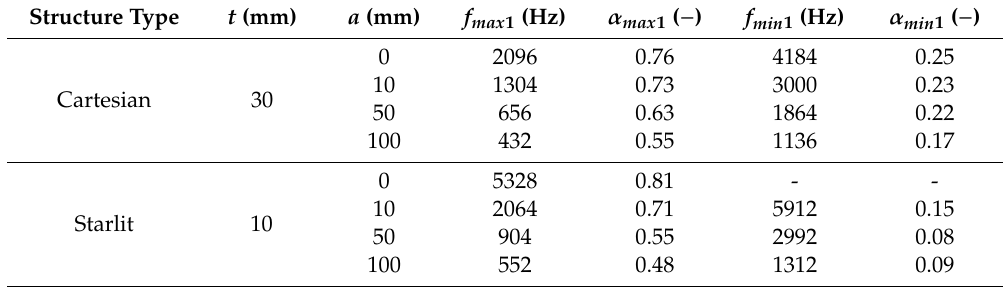
Table 2. Primary sound absorption maxima and minima and their corresponding frequencies depending on the air gap size for the investigated ABS samples with Cartesian and Starlit